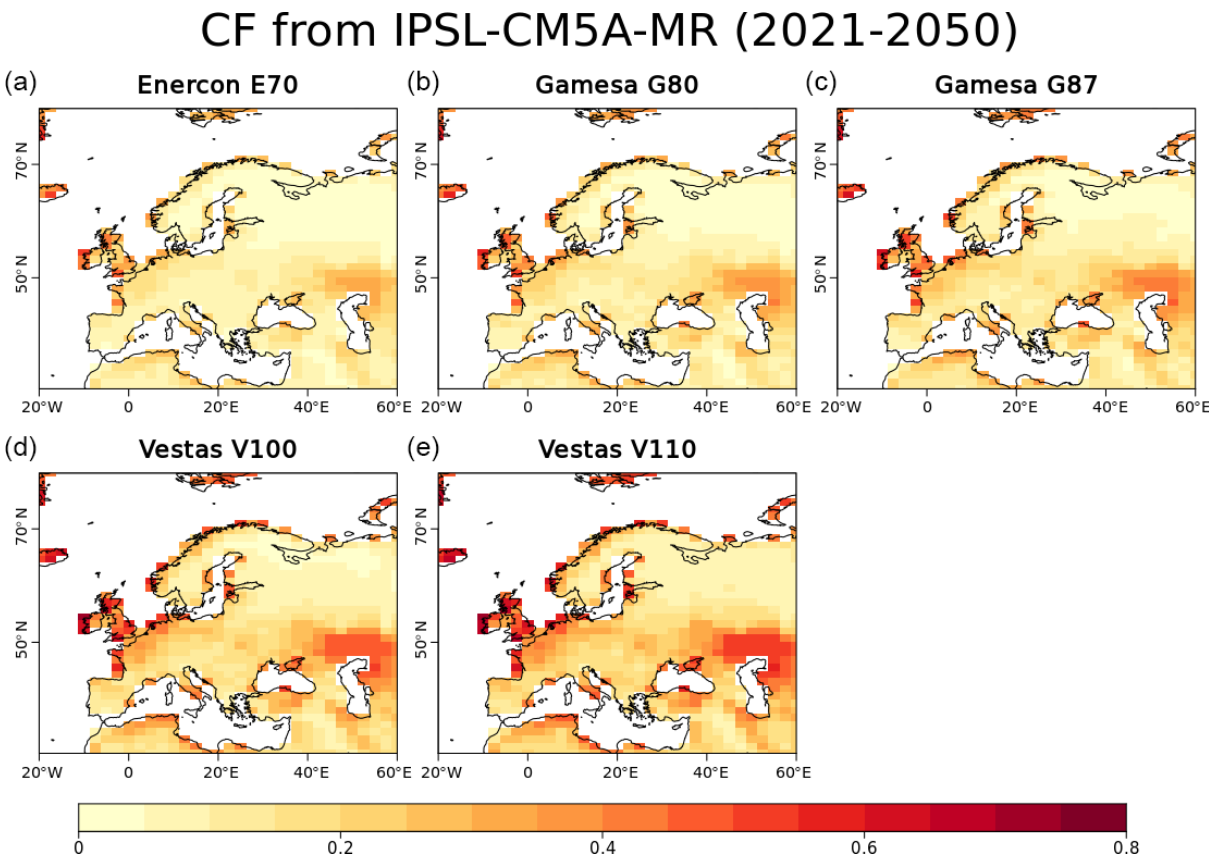
Figure 11. Wind capacity factor for five kinds of wind turbines: Enercon E70 (a) , Gamesa G80 (b) , Gamesa G87 (c) , Vestas V100 (d) , and Vestas V110 (e) using the IPSL-CM5A-MR simulation for the RCP8.5 scenario during the period 2021–2050 (see Sect. 3.3.4 for details on recipe_capacity_factor.yml